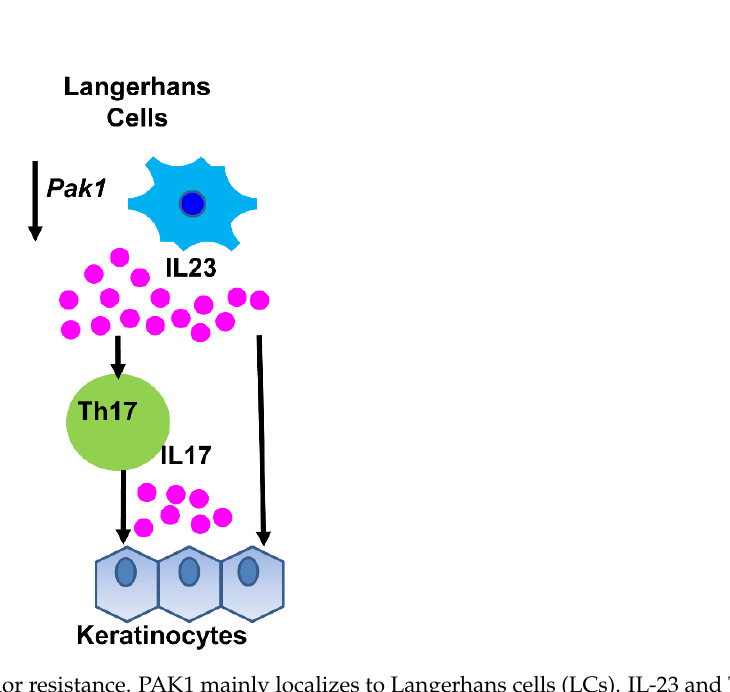
Figure 3. Mechanism of action of PAK in tumor resistance. PAK1 mainly localizes to Langerhans cells (LCs). IL-23 and Th 17 cell numbers were elevated in the skin of F 1 - Pak1 +/ − mice. F 1 - Pak1 +/ − mice had a lower number of epidermal stem cells in the skin bulge, which may be due to the abnormal proliferation of keratinocytes, resulting in tumor resistance.